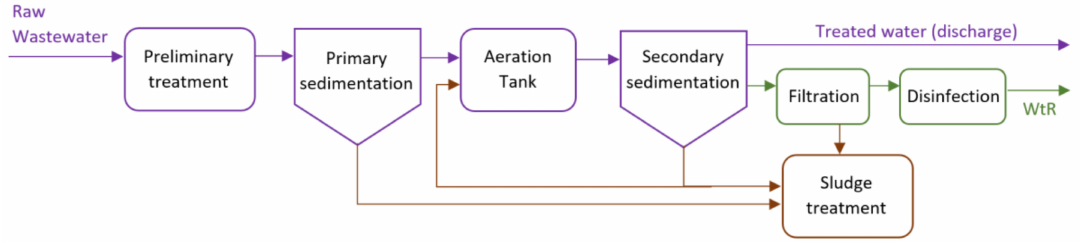
Figure 3. Schematic configuration of Espinho WWTP, with the additional processes needed to produce WtR.